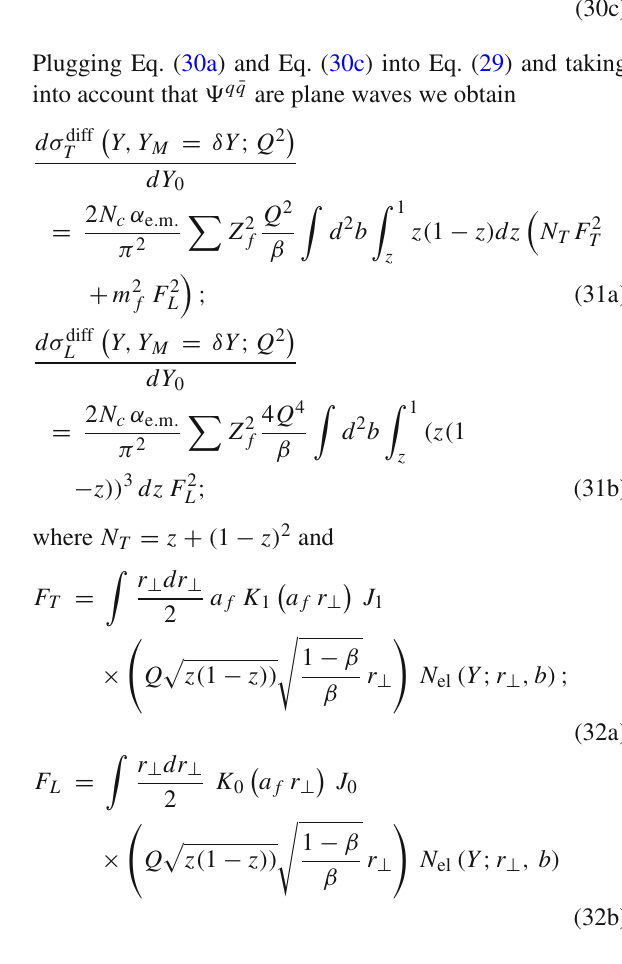
a small value, but is of the order of 1, and, therefore, we cannot use the small sizes of N 3 Eq.